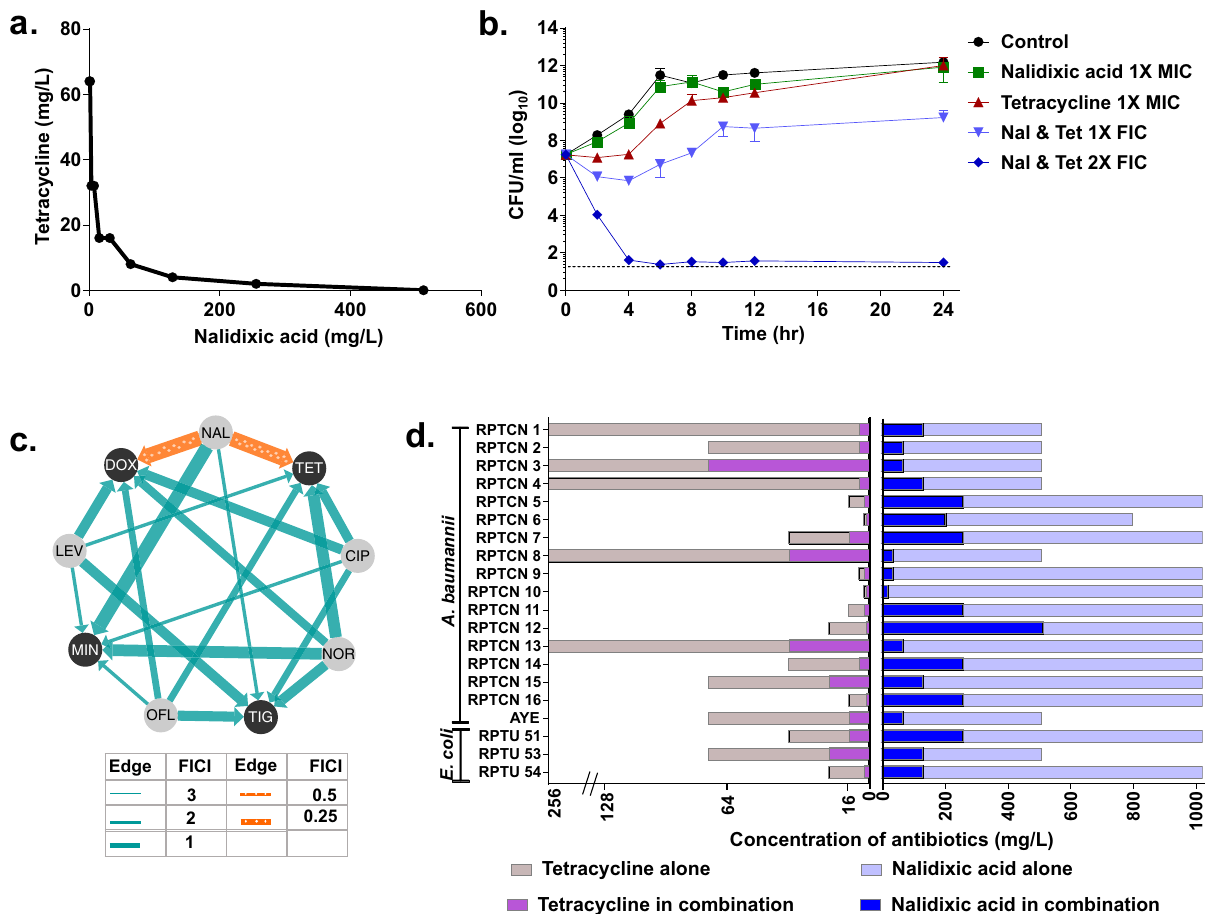
Fig. 1 Nalidixic acid and tetracycline synergy against A. baumannii and E. coli . a Isobologram of nalidixic acid and tetracycline showing synergistic action of two antibiotics against A. baumannii AYE. b Time-kill curve of nalidixic acid and tetracycline combination against A. baumannii AYE: nalidixic acid and tetracycline at 1× FIC (0.25× MIC of both antibiotics) decreased the bacterial count by 2 log 10 CFU/ml, whereas 2× FIC (0.5× MIC of both antibiotics) decreased bacterial count by 6 log 10 CFU/ml. The CFU detection limit in this experiment corresponds to 30 CFU/mL. Data are represented as mean with SD from three independent experiments. c Drug – drug interaction network of quinolone and tetracycline class in A. baumannii AYE. Nodes represent different antibiotics, edges represent synergy (orange) or no interaction (blue), and thickness re fl ects the Fractional Inhibitory Concentration Index (FICI). Interaction network was created with Cytoscape version 3.8.0. CIP, cipro fl oxacin; DOX, doxycycline; LEV, levo fl oxacin; MIN, minocycline; NAL, nalidixic acid; NOR, nor fl oxacin; OFL, o fl oxacin; TET, tetracycline; TIG, tigecycline. d Concentration of tetracycline (dark purple) and nalidixic acid (dark blue) in combination, compared to tetracycline alone (light pink) and nalidixic acid alone (light blue) in clinical strains of A. baumannii and E. coli